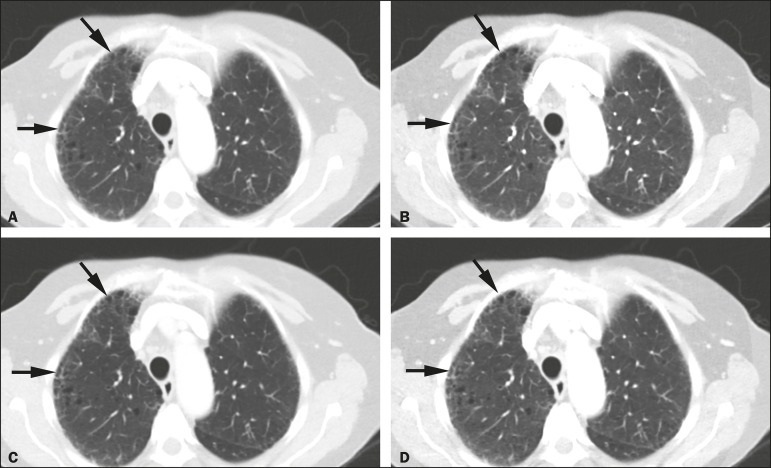
Transverse contrast-enhanced DECT images of a 73 year-old-female
(BMI = 23.4 kg/m2) who was referred for staging of
lung cancer. Standard-of-care monochromatic images at 60 keV
(A) and 40 keV (B) demonstrate
findings consistent with interstitial lung disease (pulmonary
fibrosis) in the right upper lobe. Reduced-dose monochromatic
images at 60 keV (C) and 40 keV (D)
demonstrating identical findings. Overall image quality was
deemed optimal at both dose levels.